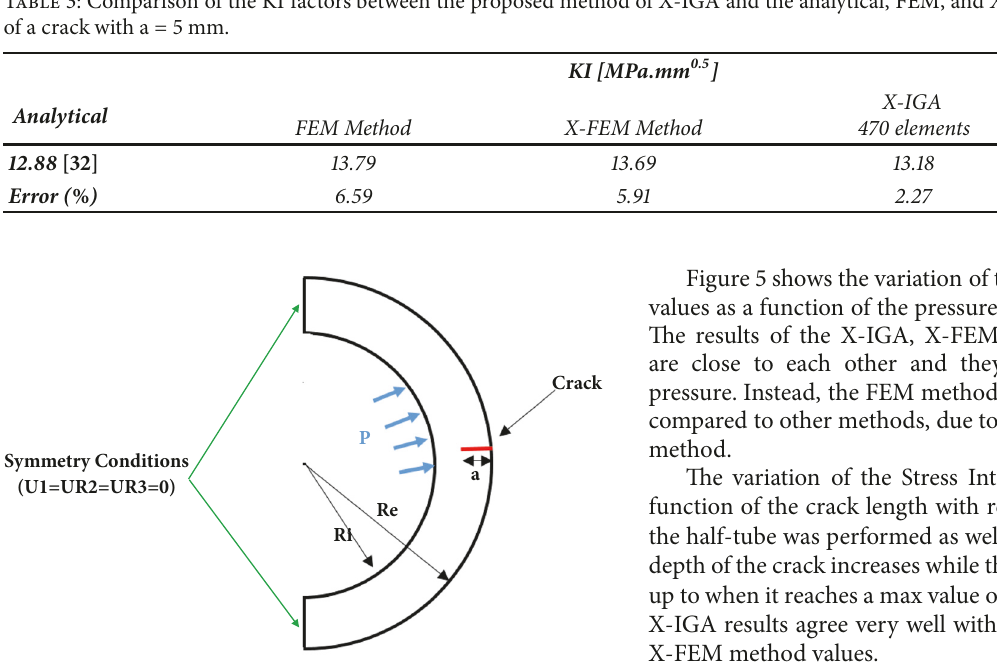
Figure 3: Annular tube with an axial crack and its boundary